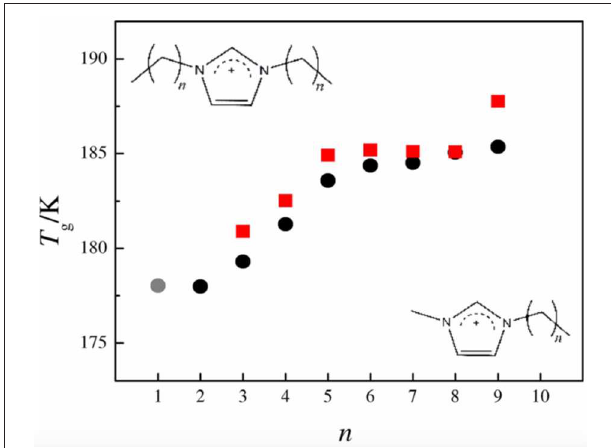
FIGURE 7 | (A) Melting points vs. glass transition temperatures for PILs reported by Belieres and Angell (2007). (Reprinted with permission from Belieres and Angell, 2007. Copyright (2007) American Chemical Society) (B) T g values as a function of molar volume (V m ) for PILs reported by Xu and Angell (2003). The line through the points is a guide to the eye. [From Xu and Angell (2003). Reprinted with permission from AAAS].